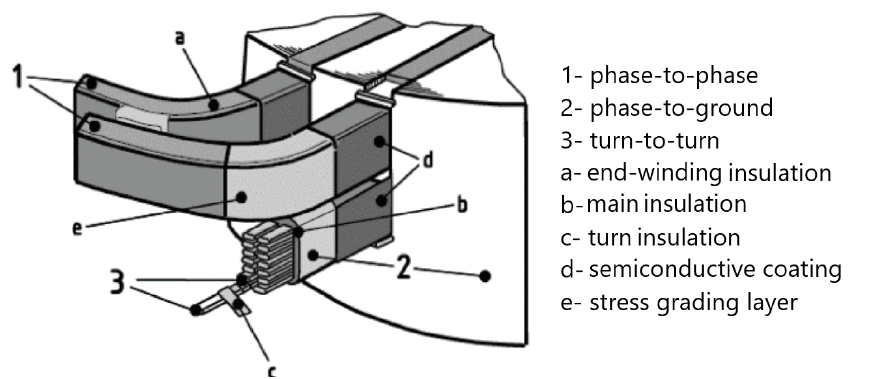
Figure 2. Preformed stator winding, adapted from